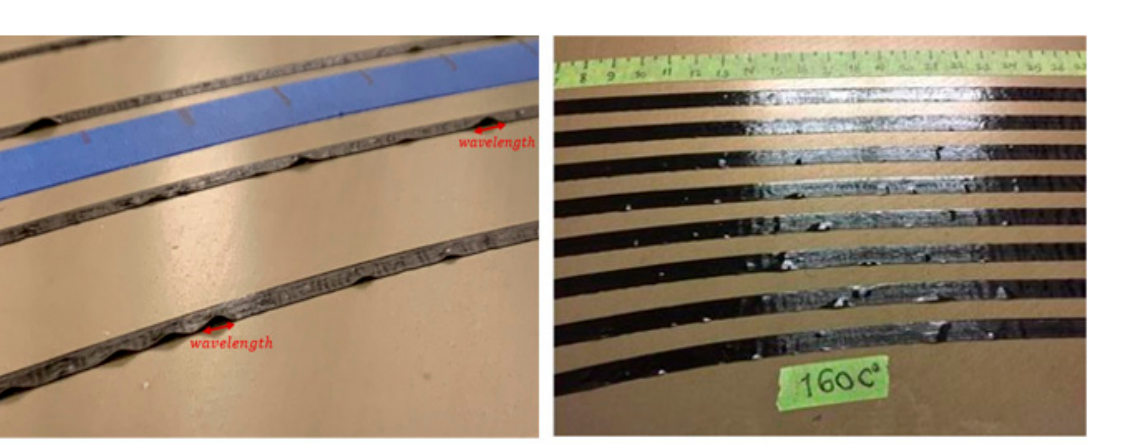
Figure 3. Steered prepreg on aluminum tool and wrinkle formation generated in tows.